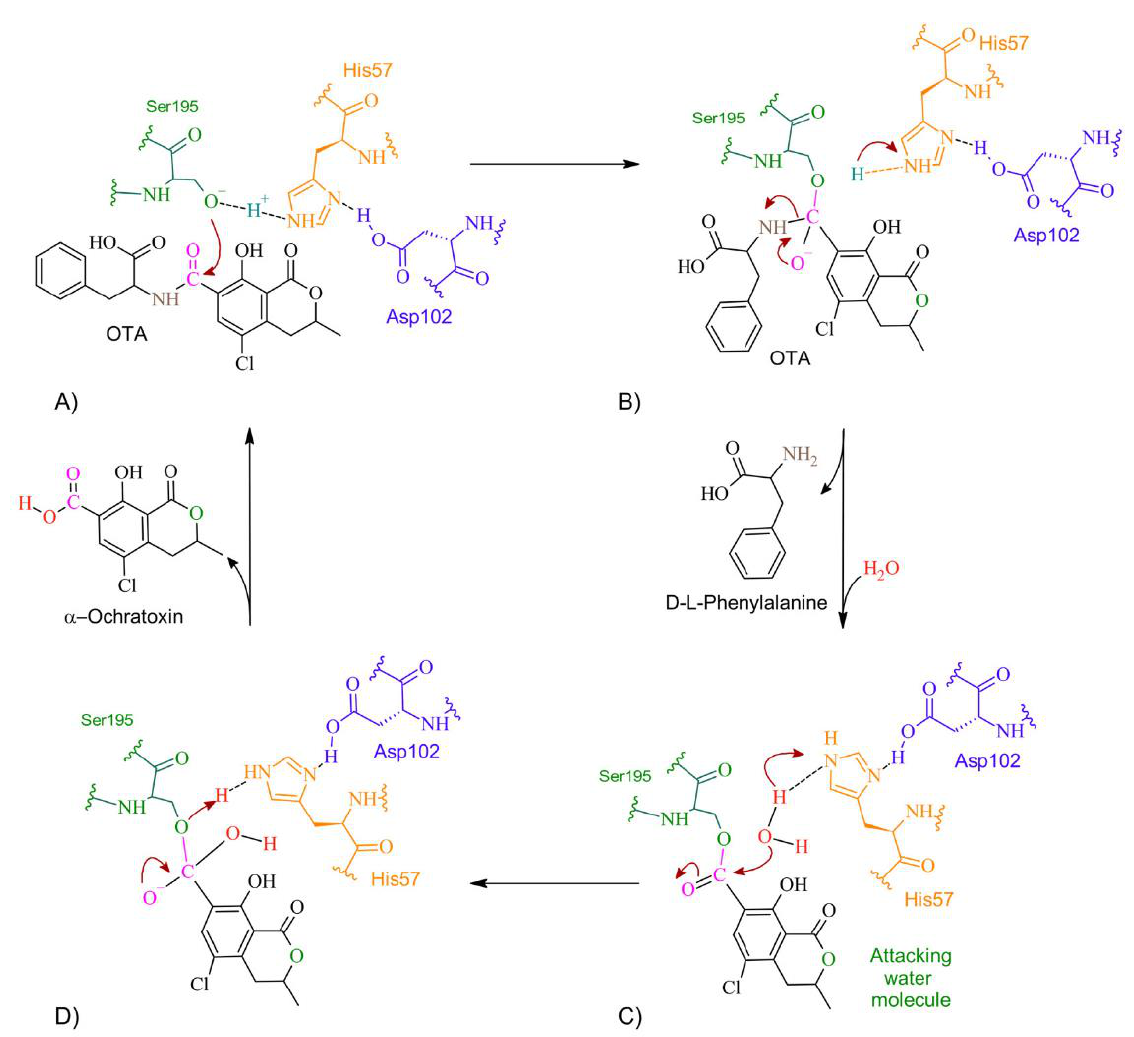
Figure 15. The detoxifying mechanism in OTA by trypsin. ( A ) Ser195 attacks the carbonyl of OTA’s peptide bond. ( B ) An intermediate is formed between Ser195 and the carbonyl group. There is an electron rearrangement. The carbonyl double bond with oxygen is restored and the peptide bond is broken. ( C ) D-L-phenylalanine is released, and a water molecule enters. His57 attacks the proton of water. The oxygen attacks the carbonyl, which shifts an electron pair from the double bond to the oxygen on the carbonyl. ( D ) The double bond of oxygen with carbon is re-established. The active site is regenerated by transferring a proton from His57 to Ser195. The molecule of α -ochratoxin is released.